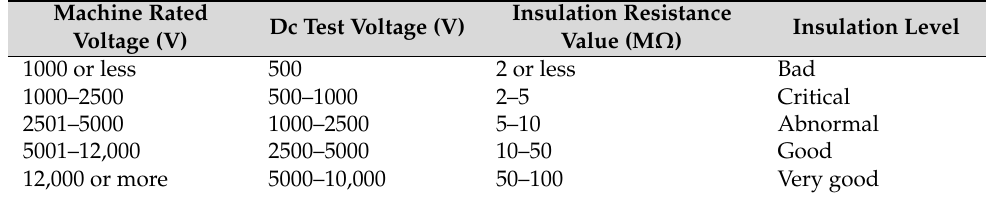
Table 3. Standard test voltages and recommended insulation resistance values [59,61].